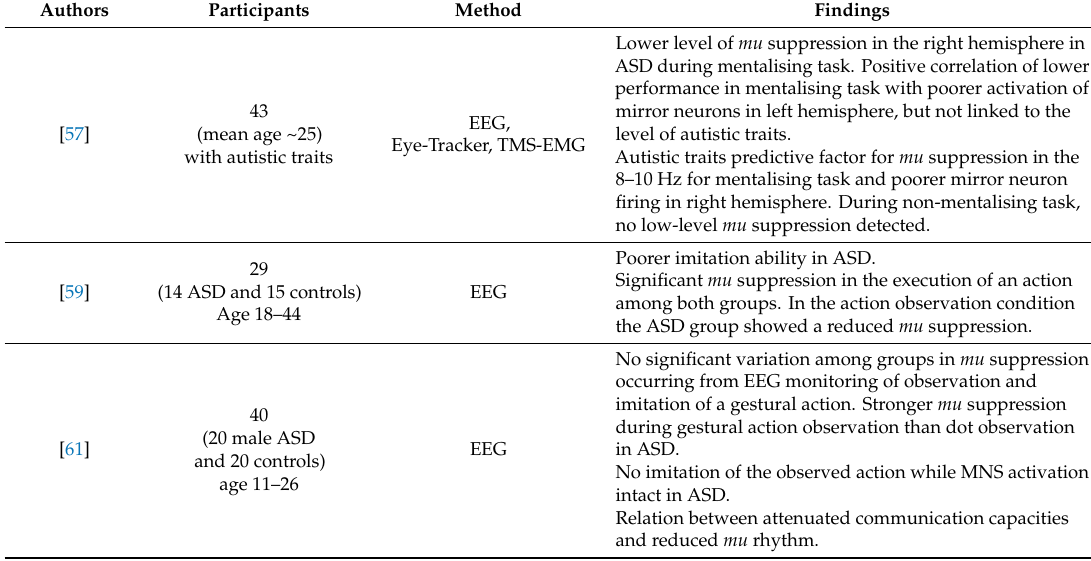
Table 1. Overview of the selected research studies for this